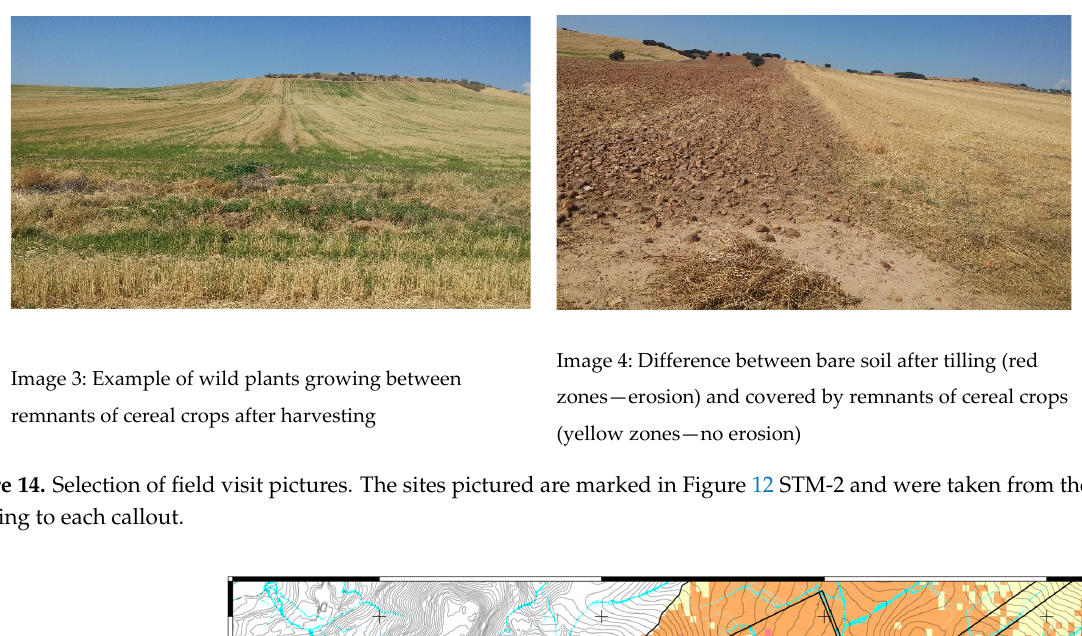
Image 2: Sedimentation processes. Example of dark green areas